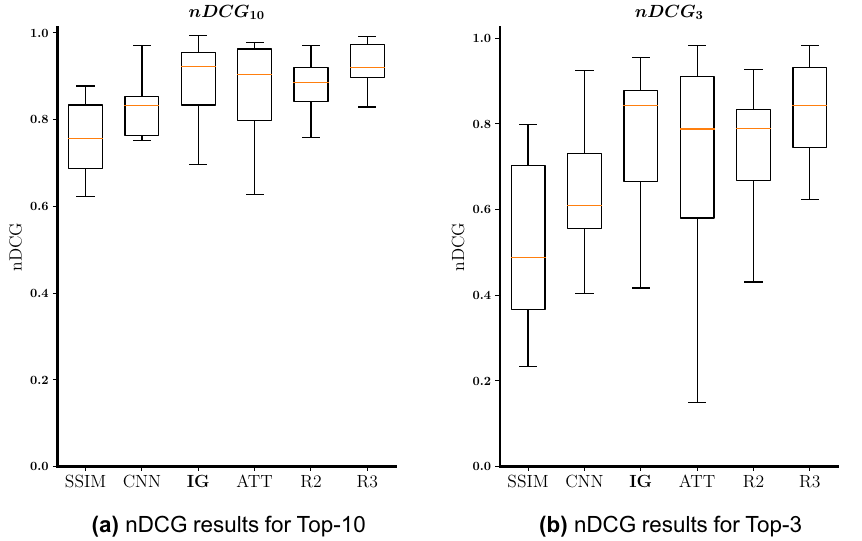
Figure 5. Box-and-whisker plots regarding the nDCG results for the pleural effusion Top-10 ( a ) and Top-3 ( b ) retrieved images. SSIM is the statistically-based baseline, CNN is the CNN-based baseline, IG is the proposed interpretability-guided approach, ATT is the attention method, R2 is the ranking provided by the second board- certified radiologist, and R3 is the ranking provided by the third board-certified